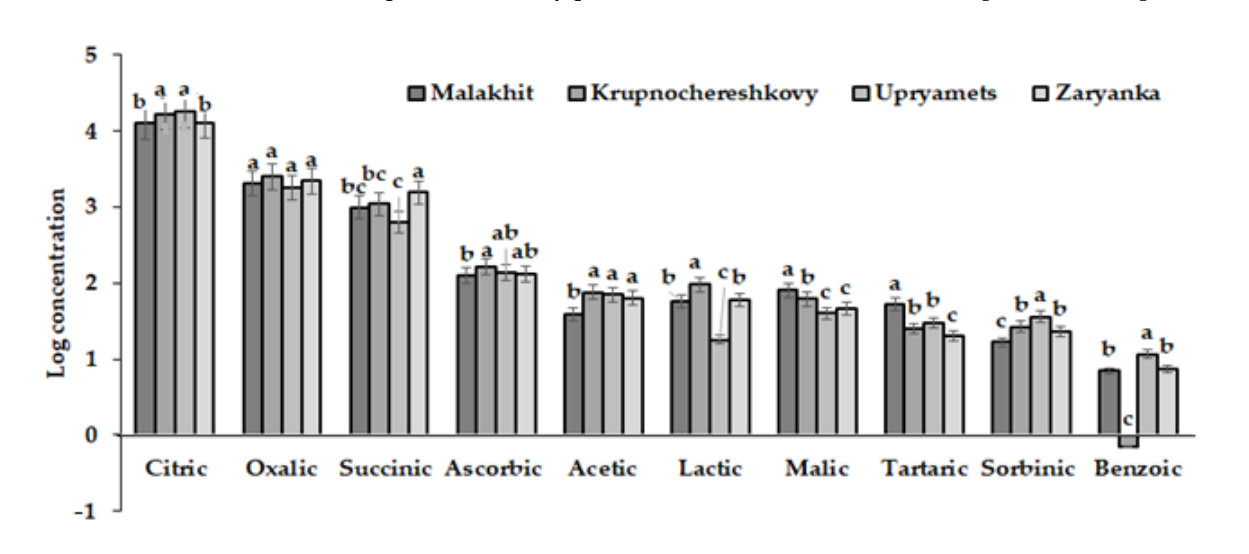
Figure 3. Juice organic acids profile of the four rhubarb cultivars examined. For each acid, values with the same letters did not differ statistically according to Duncan test at p < 0.05.